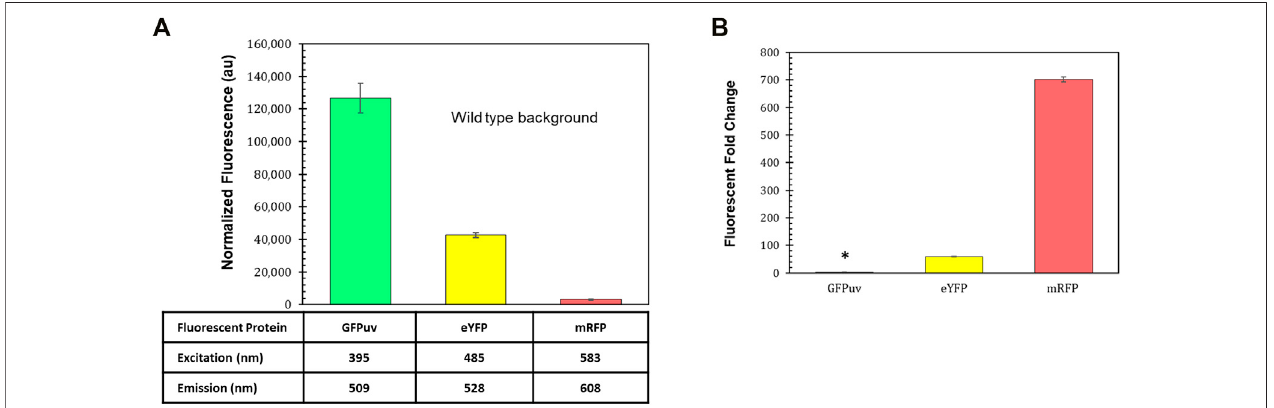
FIGURE 2 | Fluorescent reporters and background fl uorescence. (A) Average fl uorescence of wild type R. palustris normalized to absorbance (660 nm), in triplicate, at the emission and excitation wavelengths for GFPuv, eYFP, and mRFP (Materials and Methods). Error bars represent the population standard deviation. (B) Fluorescentfoldchangeaverageof R.palustris BBR1-kan-GFPuv,BBR1-kan-eYFP,andBBR1-kan-mRFPstrainsgrownintriplicate.300 μ g/mlkanamycinsulfatewas addedtothemediaforthemutantstrainsbutnotwildtype R.palustris (MaterialsandMethods).*indicatesstatisticallysigni fi cantexpressionof3-foldfortheBBR1- kan-GFPuv strain. Error bars represent the population standard deviation.